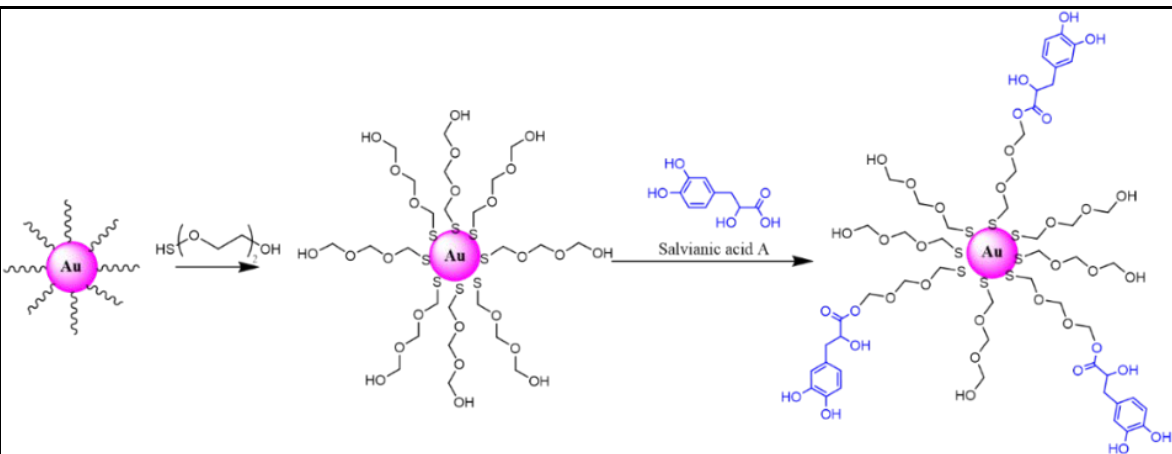
Figure 7. AuNPs (Au@- PEG3SA) Functionalized with Salvianic Acid A.